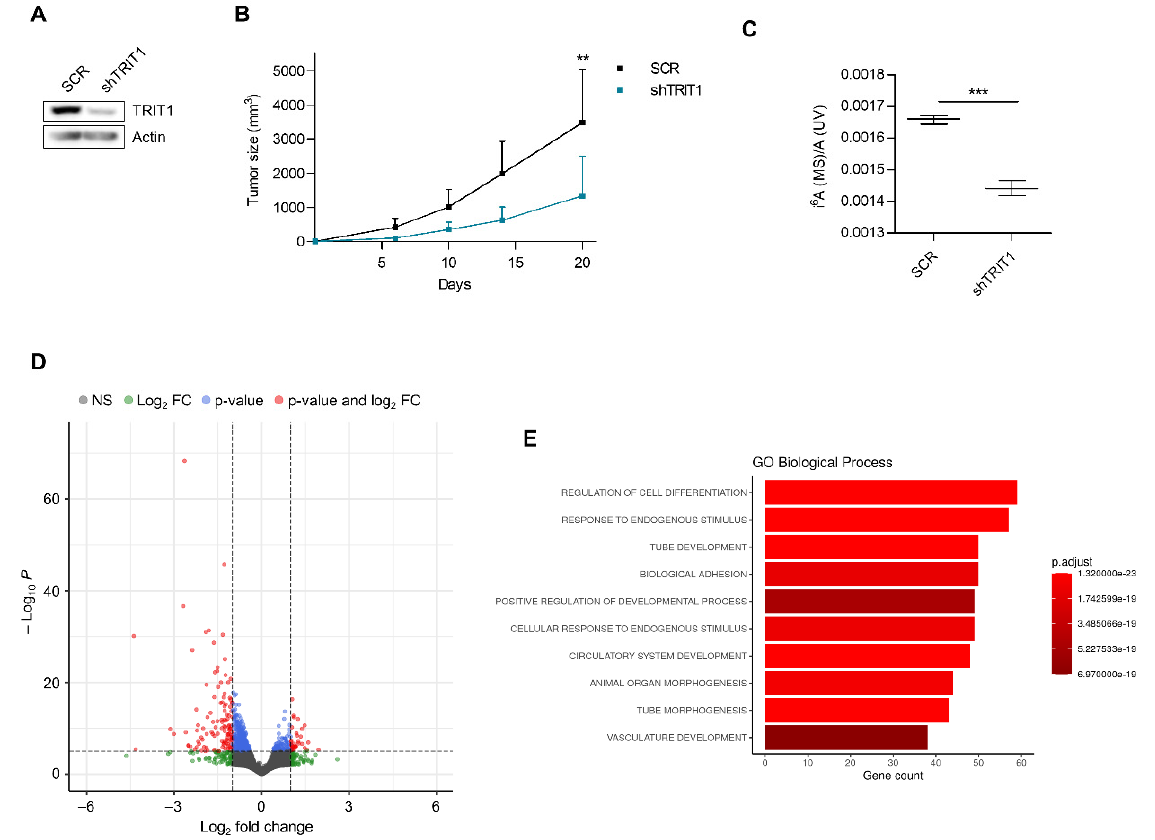
Figure 2. Effect of TRIT1 depletion on tumor growth and the RNA transcriptome of small-cell lung cancer. ( A ) Stable downregulation of the TRIT1 gene by short hairpin RNA in the small-cell lung cancer cell line DMS-273 (shTRIT1) determined by western blot analysis. SCR, scramble shRNA. ( B ) Effect of TRIT1 shRNA-mediated depletion on the growth of subcutaneous tumors in nude mice derived from DMS-273 cells (amplified and overexpressing TRIT1). There was a significant reduction in tumor volume in the TRIT1 shRNA-depleted cells. Data are summarized as the mean and standard deviation ( n = 9). Student’s t test, ** p < 0.01. ( C ) Nucleoside analysis of tRNAs by LC/MS showing that shRNA-mediated depletion of TRIT1 in DMS-273 cells induces the depletion of the i 6 A-modified nucleoside. Student’s t test, *** p = 0.0002. ( D ) Volcano plot summarizing the results of the RNA-seq experiment to find mRNAs differentially expressed in TRIT1 shRNA-depleted DMS-273 cells compared with scramble-shRNA DMS-273 cells. ( E ) Gene ontology (GO) analysis of Biological Process categories in the transcripts downregulated on TRIT1 depletion in DMS-273 cells shows the GO Biological Process category “regulation of cell differentiation” to be the most highly